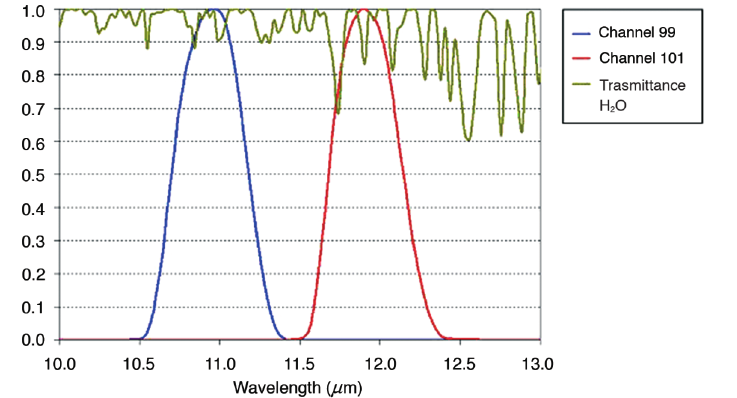
Fig. 1. MIVIS channel 99 (blue) and 101 (red) response functions versus trasmittance